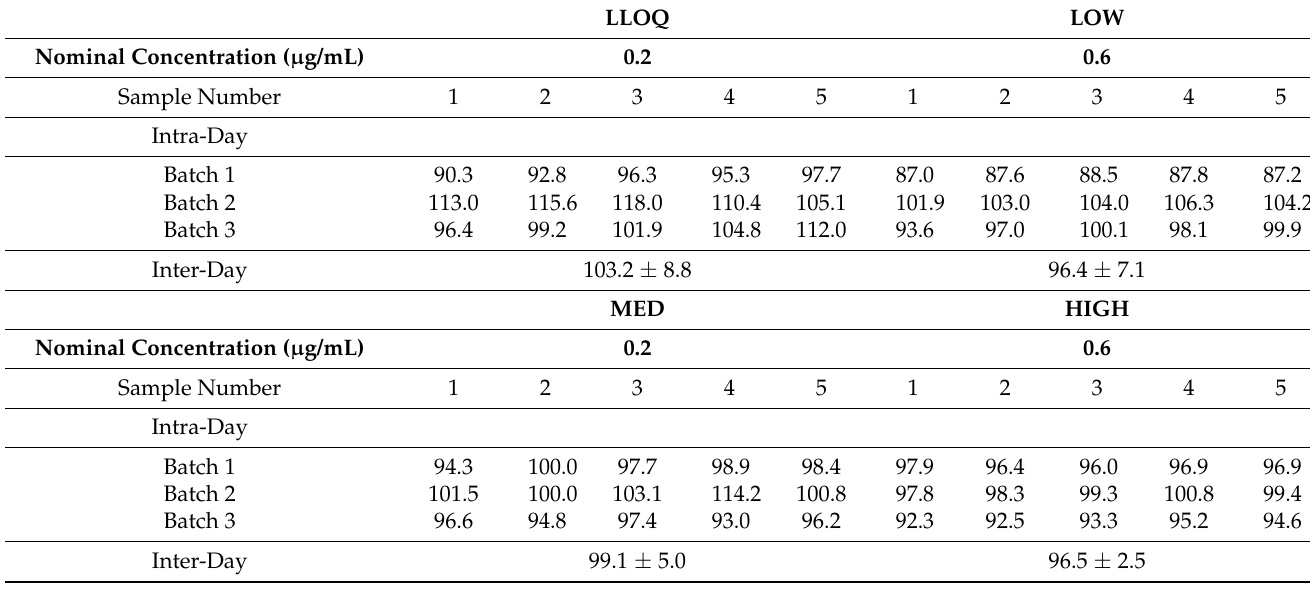
Table 5. Intra-day and inter-day accuracy (%) for the quality controls.